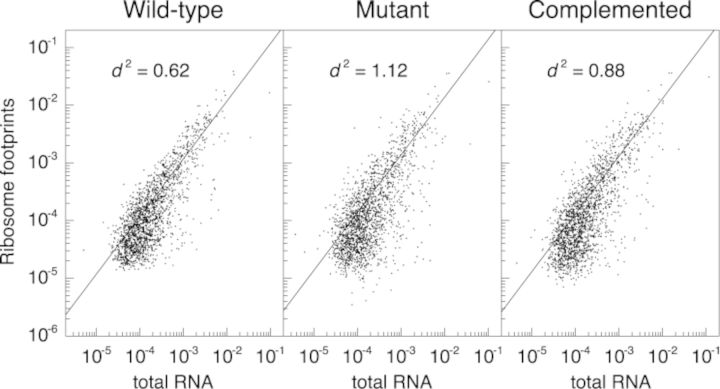
Gene expression is globally perturbed in the absence of LepA. Normalized gene-by-gene coverages are compared between ribosome footprints and total RNA in WT, mutant and complemented strains (as indicated). A measure of spread, \documentclass[12pt]{minimal}
\usepackage{amsmath}
\usepackage{wasysym}
\usepackage{amsfonts}
\usepackage{amssymb}
\usepackage{amsbsy}
\usepackage{upgreek}
\usepackage{mathrsfs}
\setlength{\oddsidemargin}{-69pt}
\begin{document}
}{}$d^2$\end{document}, was calculated for each of the comparisons, yielding 0.62 ± 0.02, 1.12 ± 0.02 and 0.88 ± 0.03 for the WT, M and C samples, respectively. Student's t-tests on the values of \documentclass[12pt]{minimal}
\usepackage{amsmath}
\usepackage{wasysym}
\usepackage{amsfonts}
\usepackage{amssymb}
\usepackage{amsbsy}
\usepackage{upgreek}
\usepackage{mathrsfs}
\setlength{\oddsidemargin}{-69pt}
\begin{document}
}{}$d^2$\end{document} in all three replicates yield P = 1.6 × 10−5 for the WT versus M, and P = 1.2 × 10−3 for the M versus C comparison, showing significant perturbation of translation efficiencies (i.e. changes in ARD values) due to loss of LepA.